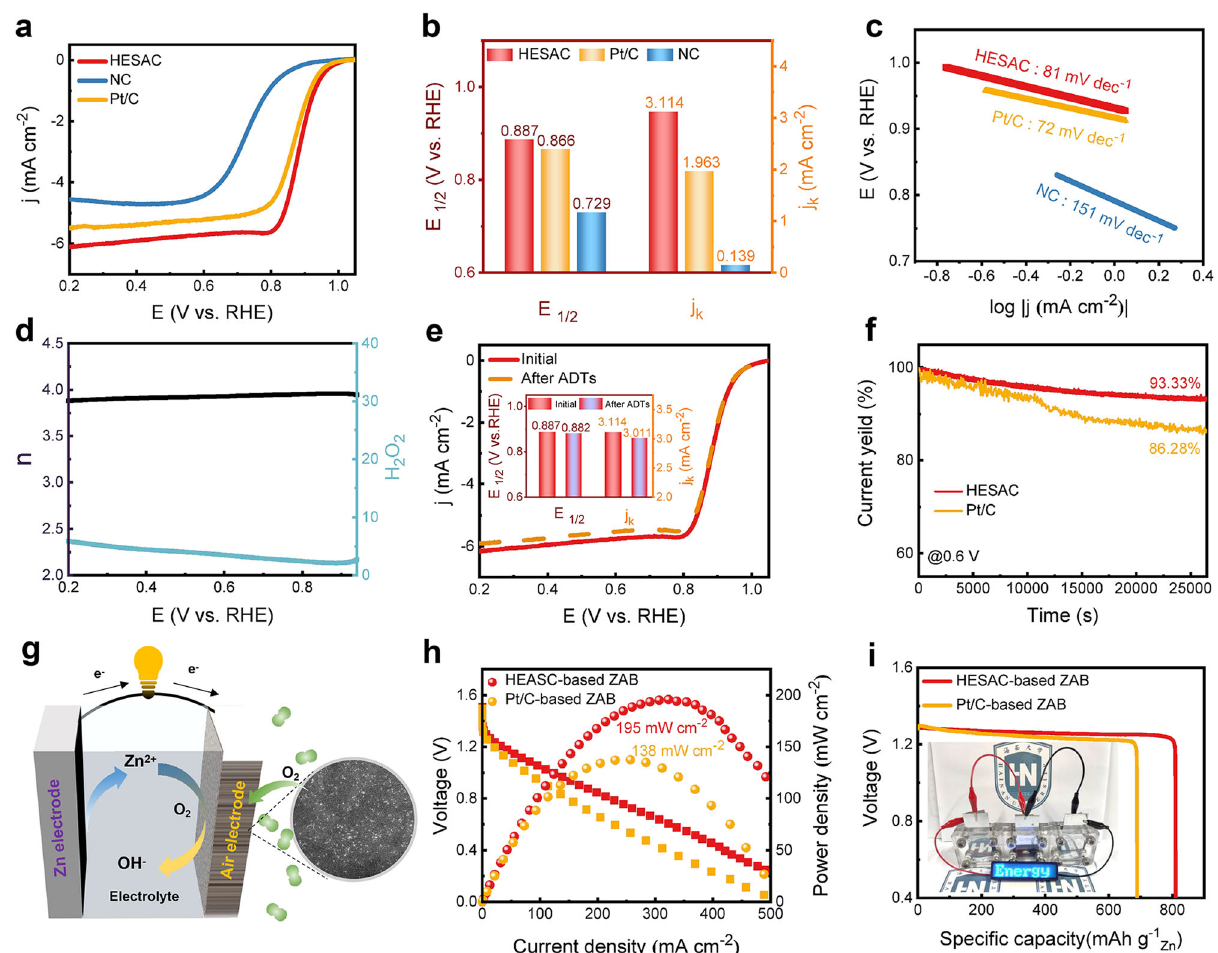
Fig.3|ORRperformanceofthepreparedquinaryHESACs(FeCoNiCuMn).a LSV curves,( b )comparisonofE 1/2 and j k ,and( c )Tafelslopesofthe HESAC,NC,andPt/ C, ( d ) RRDE and ( e ) durability data ofprepared HESAC,( f ) CA results ofthe HESAC and Pt/C, ( g ) schematic diagram of assembled ZAB (the inside AC HAADF-STEM